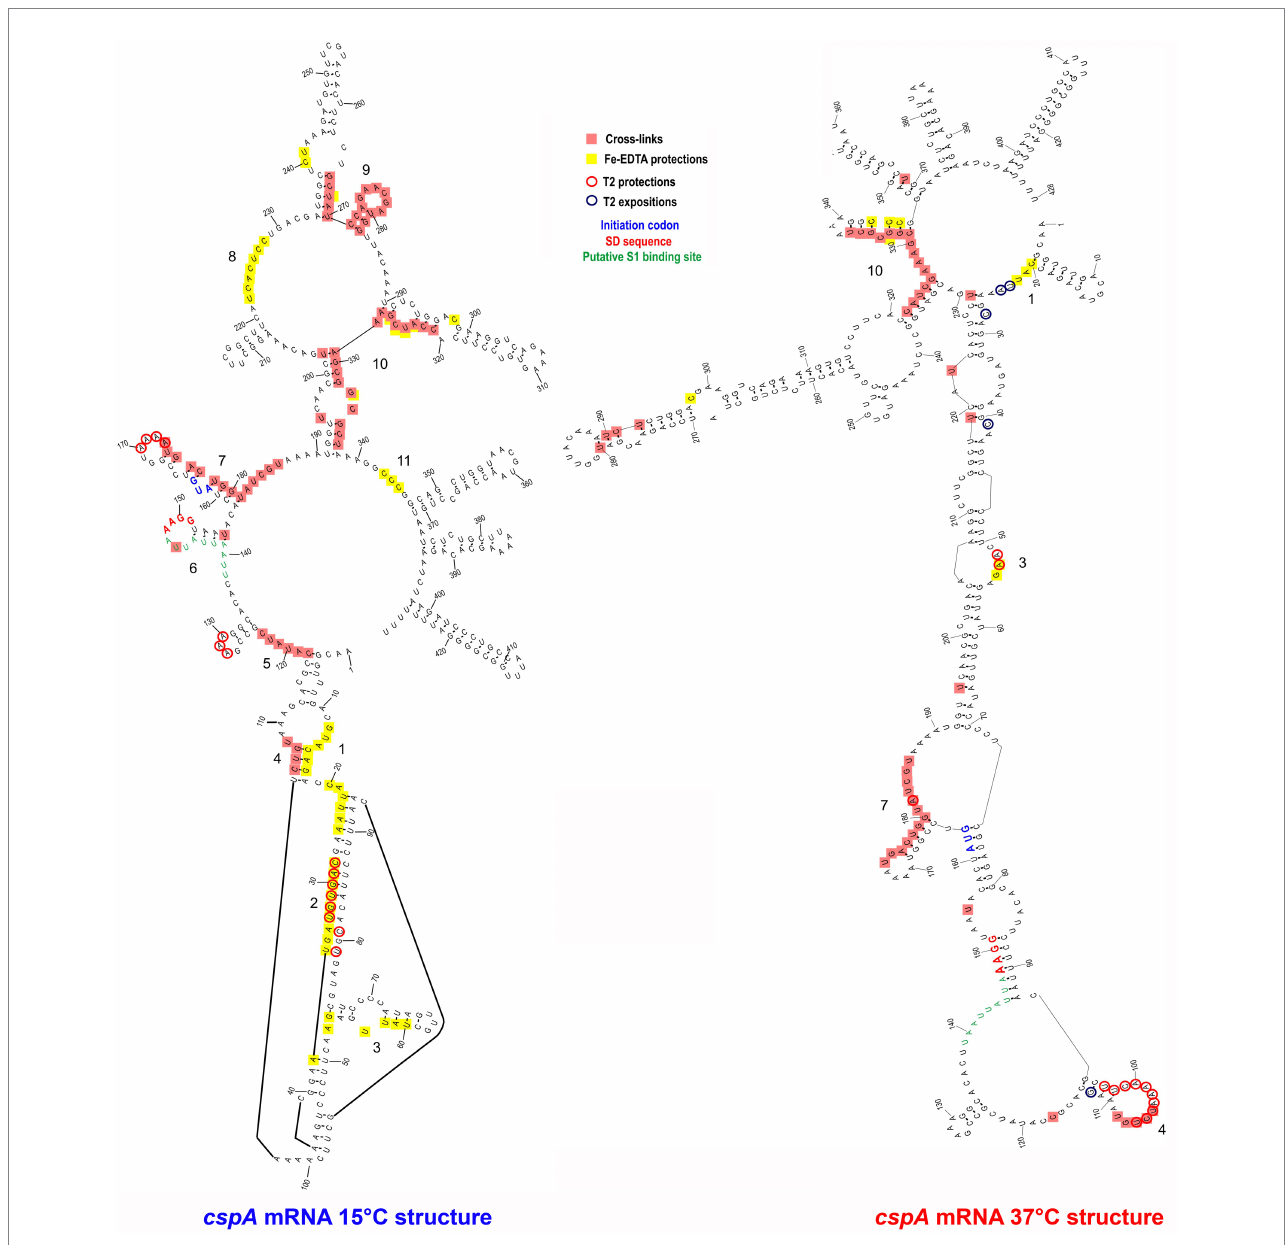
FIGURE 3 CspA bindig sites identified on both cspA mRNA forms. The footprinted/crosslinked positions reported on the structural model derive from the probing/ cross-linking/Fe-EDTA experiments performed at 15 ° C using the cspA mRNA folded in the cold-conformation or in the 37 ° C-conformation. The SD sequence (red), the start codon (blue), and the putative S1-binding site (green) are indicated. The secondary structure model of cspA mRNA is taken from Giuliodori et al.